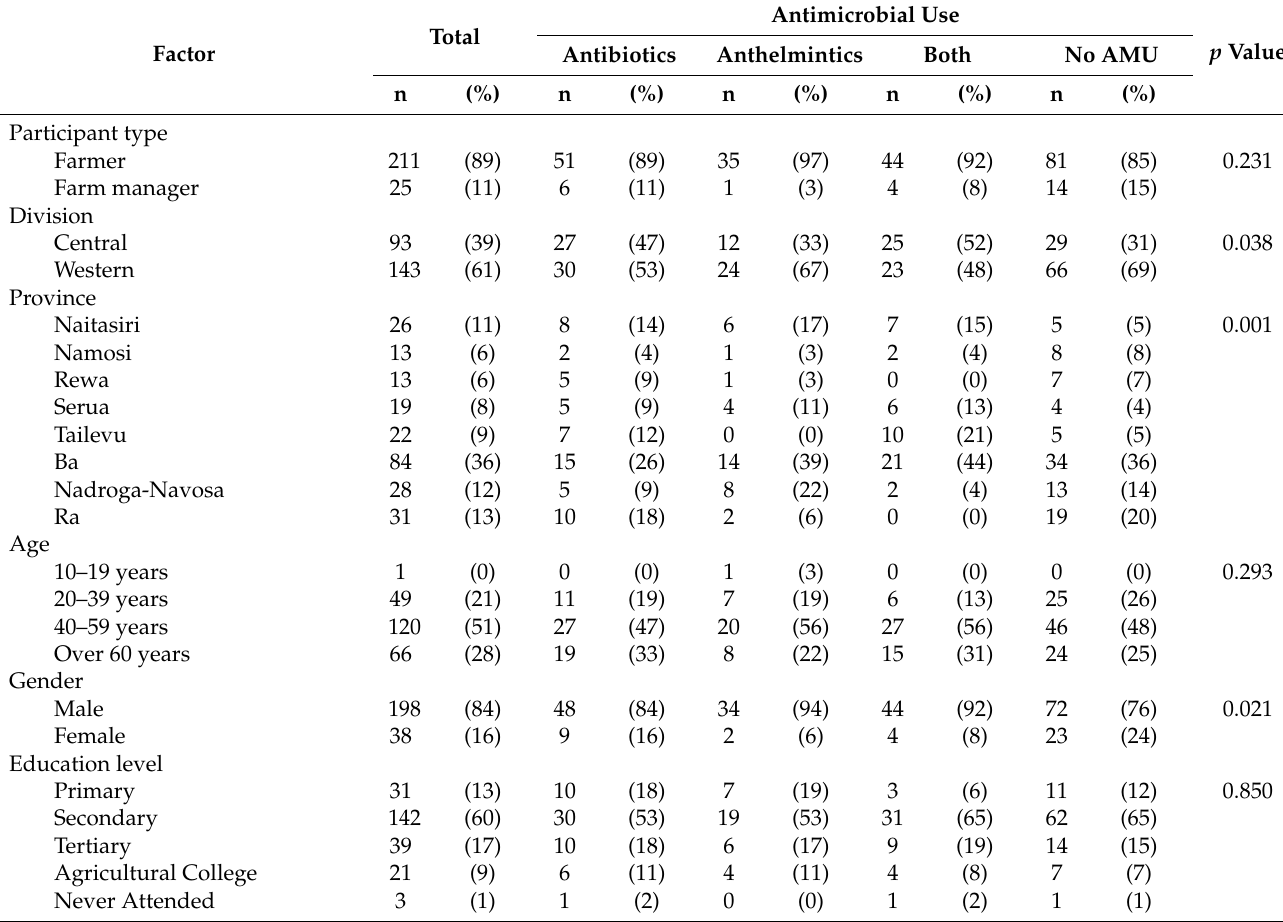
Table A1. Associations between factors (farmer, livestock production and management) and antimi- crobial use (antibiotics, anthelmintics, both and no antimicrobial use) on 236 livestock farms located in Central and Western divisions of Viti Levu,